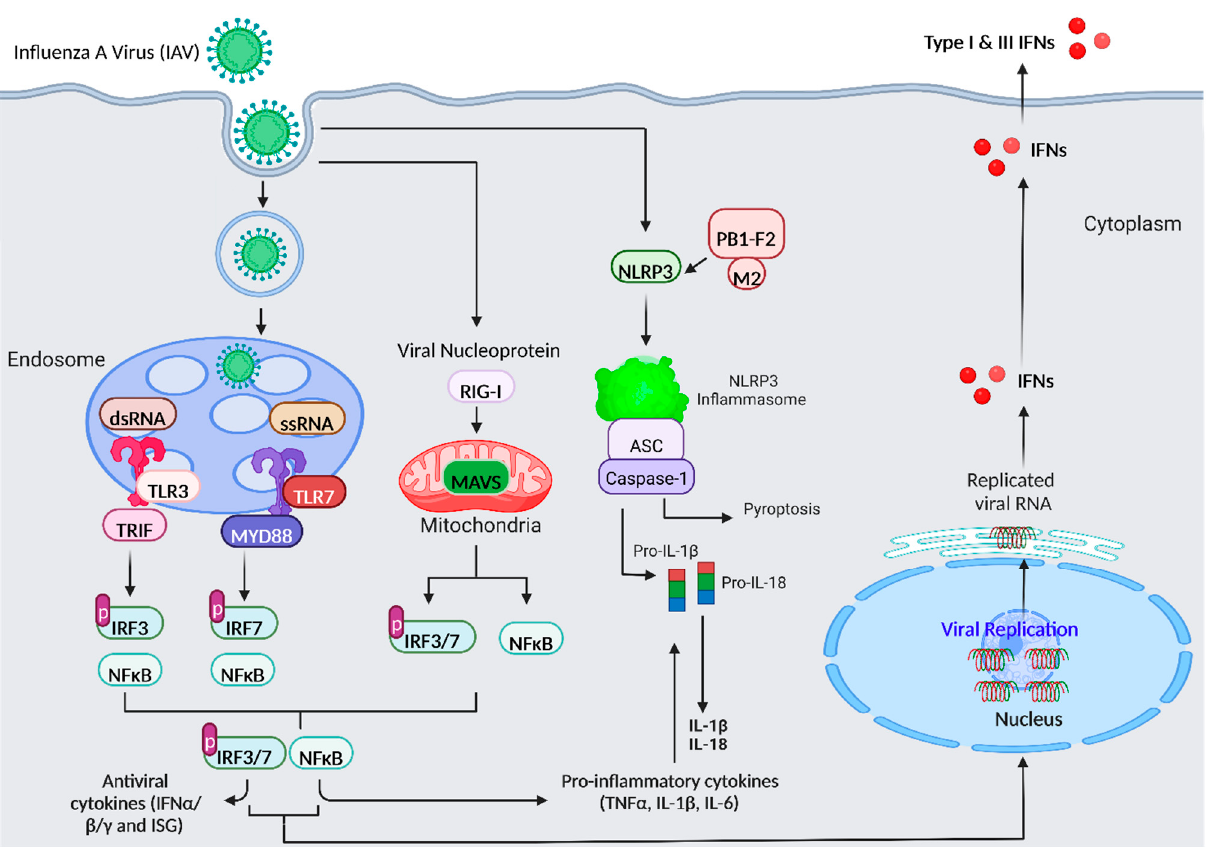
Figure 1. Schematic diagram for the innate immune response against influenza A virus (IAV) infection. The intracellular detection of IAV occurs by host pathogen recognition receptors (PRRs) such as TLR3 and TLR7. TLR3 and TLR7 signalling then activates transcription factor: nuclear factor kappa-light-chain-enhancer of activated B cells (NF- κ B) via adaptor proteins TIR-domain-containing adapter-inducing interferon- β (TRIF) and myeloid differentiation factor 88 (MyD88), respectively. Transcription factors: IRF3 and IRF7 are also activated for TLR3 and TLR7, respectively. NF- κ B functions to activate the transcription of pro-inflammatory cytokines such as tumour necrosis